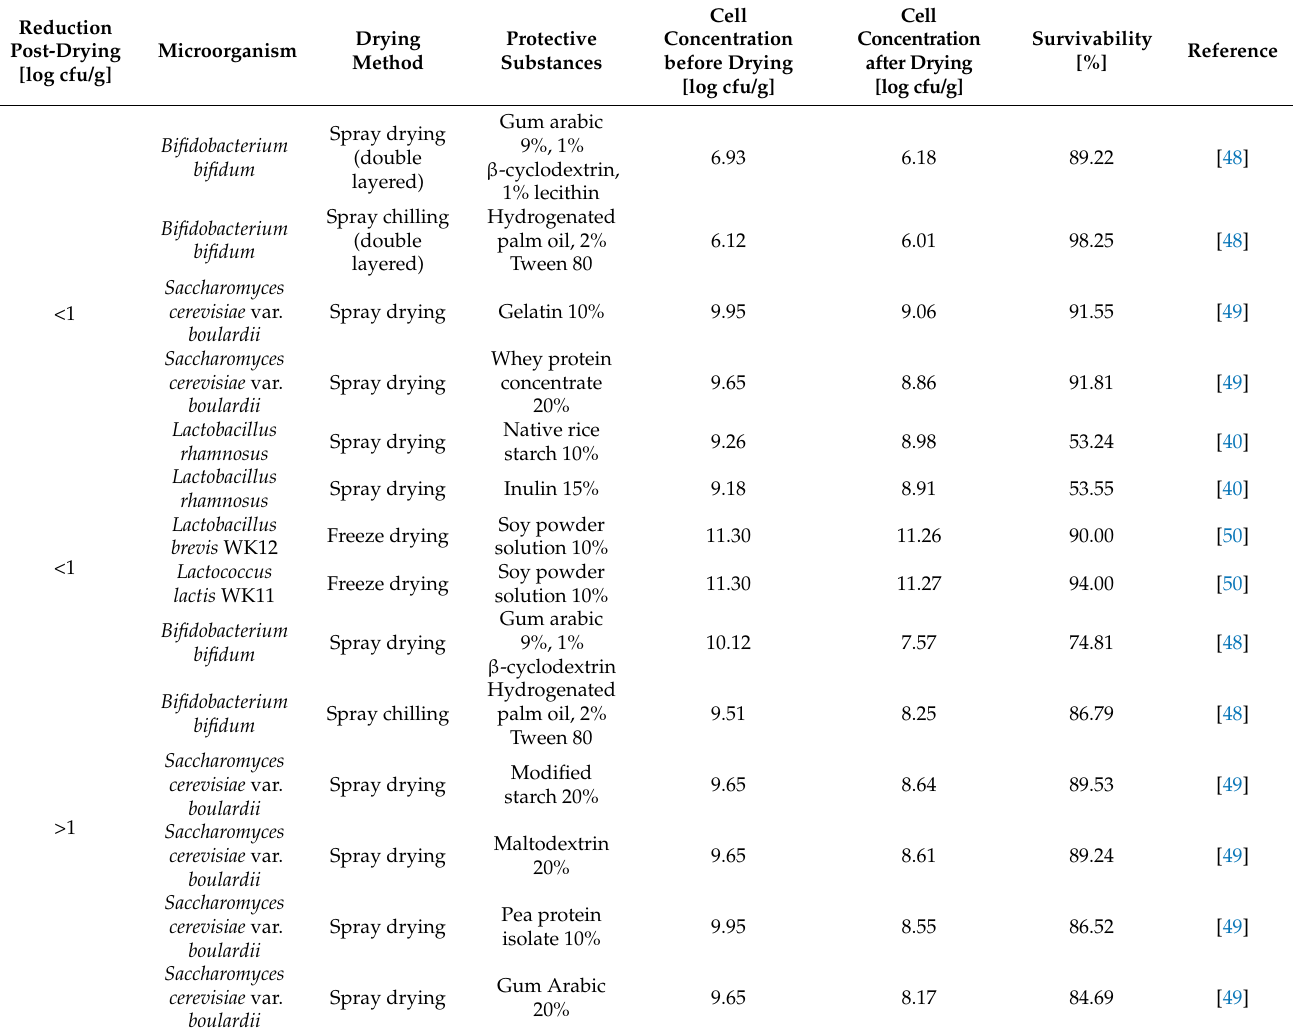
Table 2. Protective effects of different